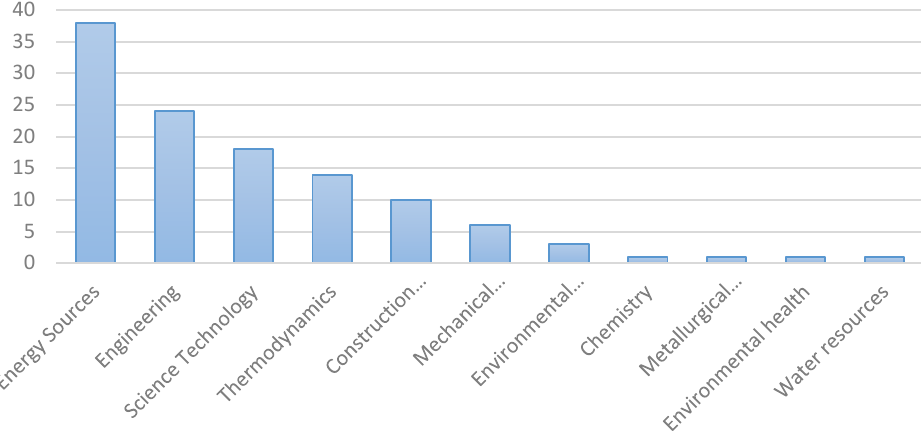
Figure 4. Classification of scientific areas for publications on residential solar heating with sample flat-plate collectors according to the Web of Science.